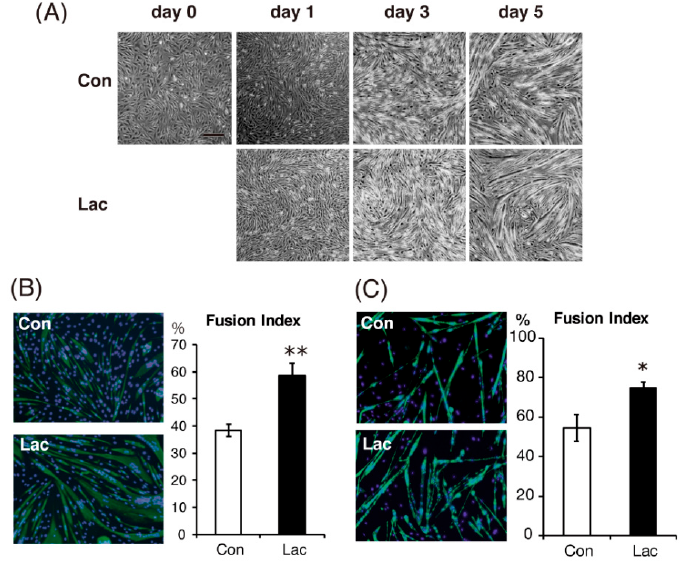
Figure 1. Lactate promoted myogenic differentiation of myoblasts. Cells were differentiated in control medium (Con) or medium containing 10 mM sodium lactate (Lac) for 5 d. ( A ) Microscopic images of C2C12 myoblasts after the induction of differentiation for the indicated days. Scale bar, 200 µ m. ( B , C ) Differentiated C2C12 cells at day 5 ( B ) and primary myoblasts at day 3 ( C ) were stained with an MF-20 anti-myosin heavy chain (MHC) antibody (green) and 4 ′ ,6-diamidino-2-phenylindole (DAPI) (blue). Fusion index (%), defined as the percentage of nuclei located within MHC-positive myotubes divided by total nuclei, was calculated as described in Methods. n = 3–4 per group. Results are expressed as mean ± SE. * p < 0.05, ** p < 0.01 vs. Con.